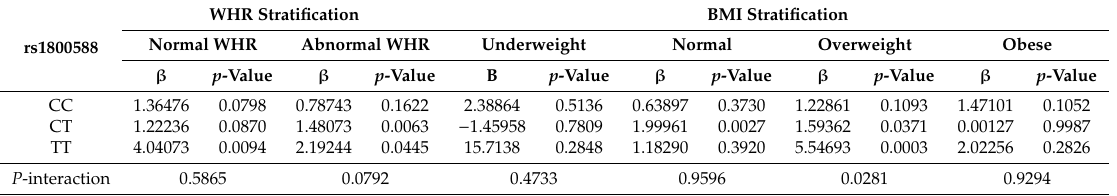
Table 6. The impact of aerobic exercise on HDL-C stratified by rs1800588 variant and obesity indexes.